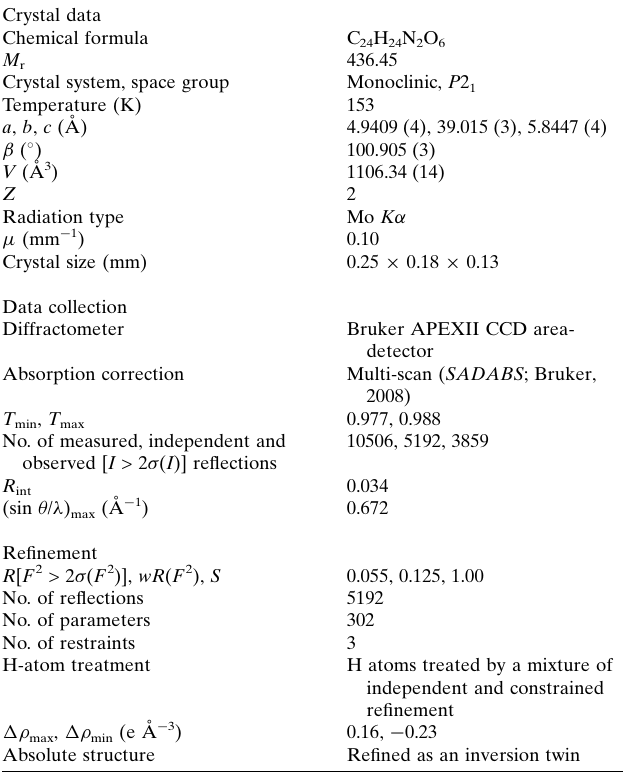
Crystal data Chemical